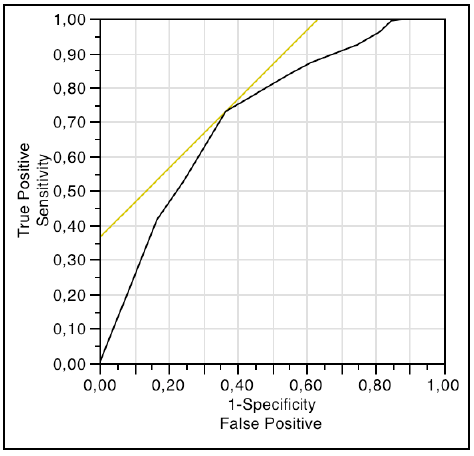
Figure 1. ROC curve analysis for comparison between scores of NRS of HS impact on sex life and FSFI-6.